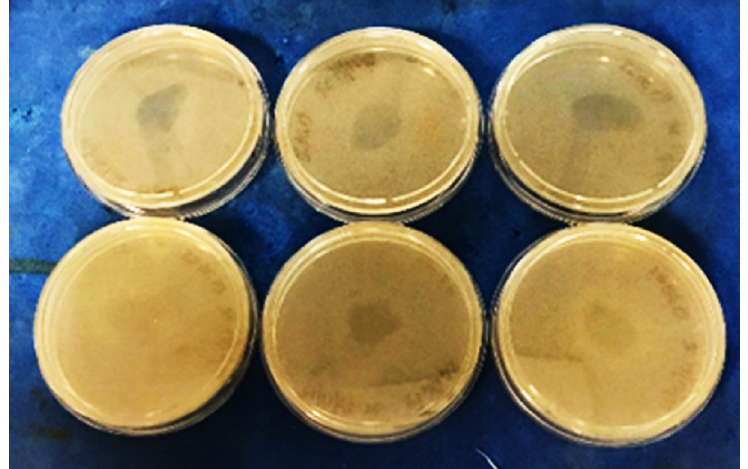
Figure 3. The figure shows RAC results for sample 6 after in vitro digestion. The presence of an inhibition zone around the inoculum was observed both in dried extracts (below) and in digested PAPs (above), both in triplicate.